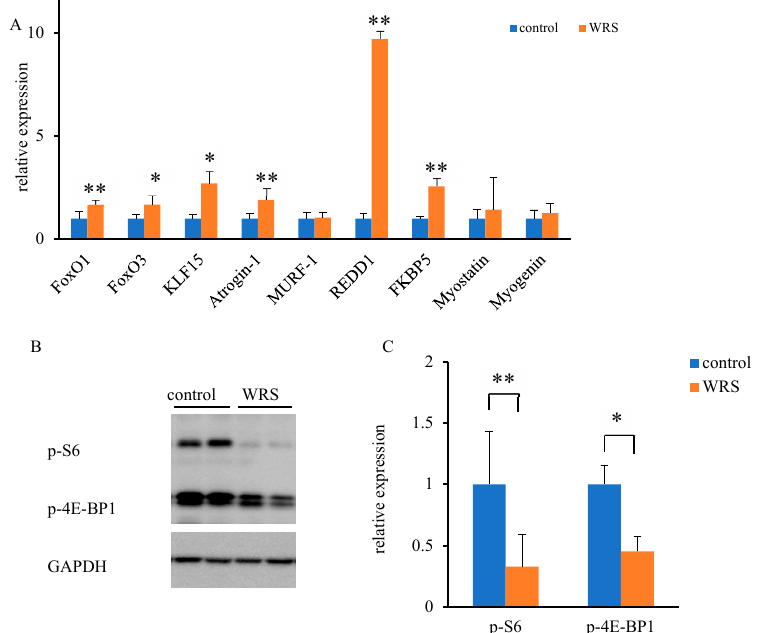
Figure 4. Expression of glucocorticoid-responsive genes under chronic stress conditions. ( A ) Expres- sion levels of genes associated with protein degradation were significantly higher in the WRS group, although myostatin, an inhibitor of muscle proliferation, and myogenin, a marker of muscle differ- entiation, remained unaffected. ( B , C ) Phosphorylation of S6 and 4E-BP1, both downstream